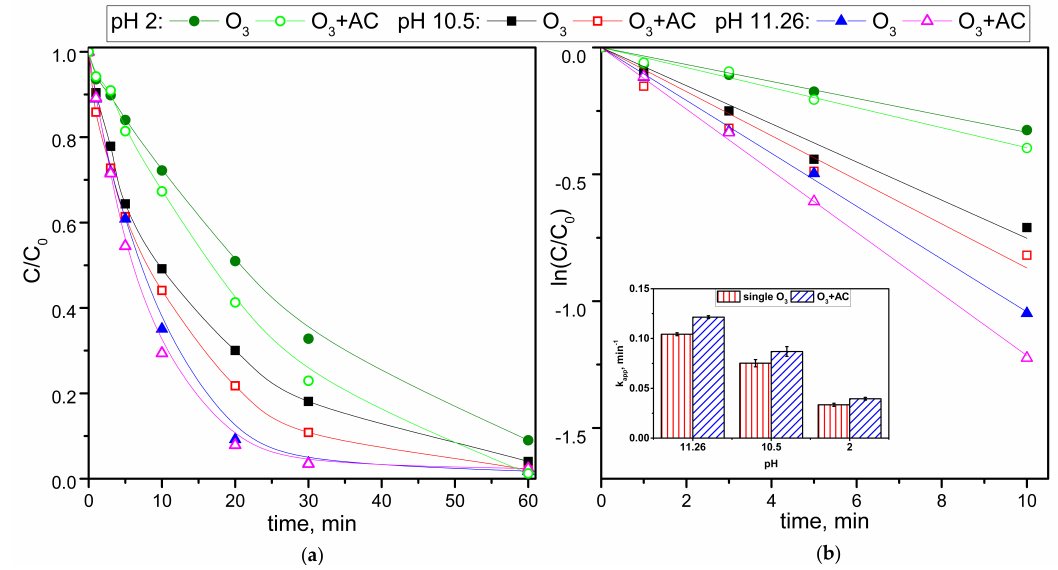
Figure 6. Decolorization rate of Reactive Black 5 dye (RB5 model solution in various pH: 2, 10.5, and 1.26 for stable ozone dose (C O 20 mg / L, Q 20 L / h, C RB5 0.5 g / L, and C AC 0.5 g / L): color removal vs 3 time ( a ), pseudo-first order decolorization rate ( b